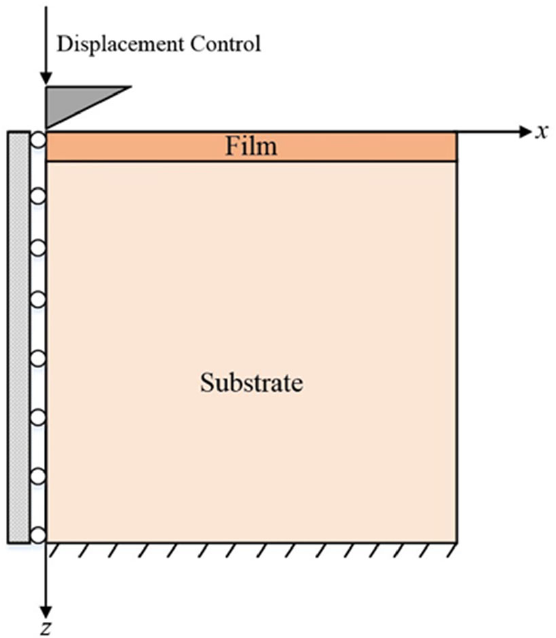
Figure 2. Schematic diagram of the indentation model with a film/substrate structure under a Berkovich indenter.